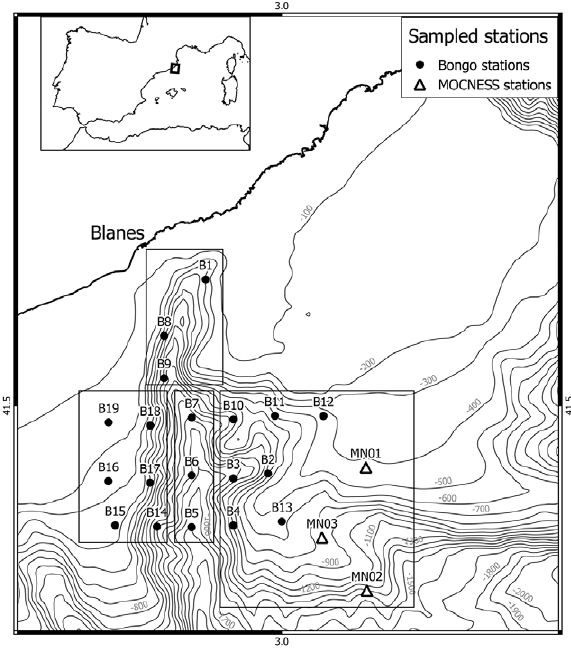
Fig. 1. – Sampling locations in the Blanes submarine canyon area. Canyon zones are indicated by rectangles: canyon head (top), downstream wall (bottom left), canyon axis (bottom centre), and upstream wall (bottom right).